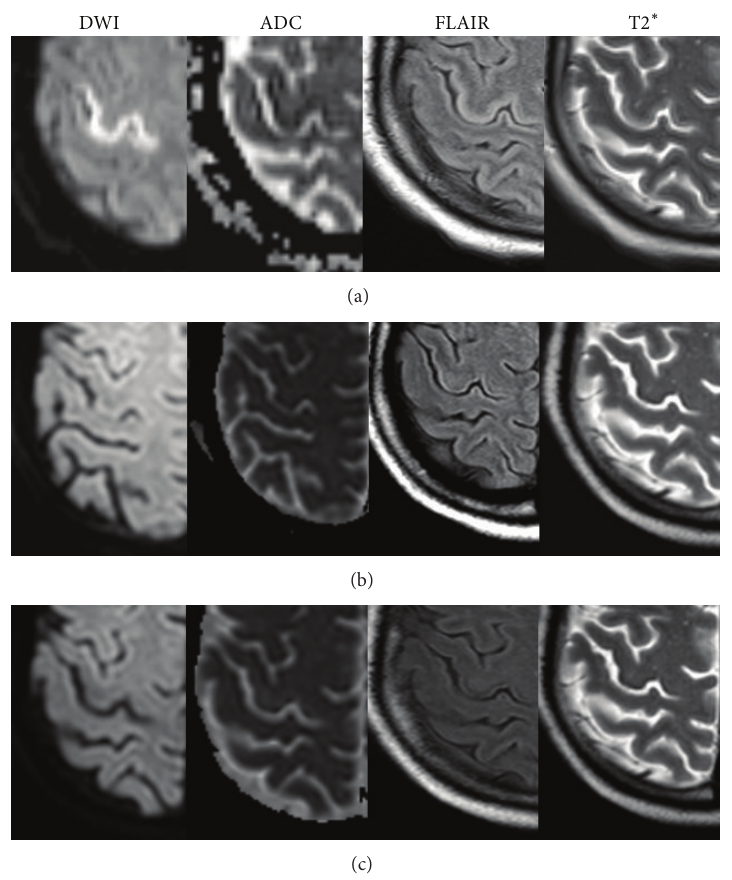
Figure 4: Laminar cortical infarcts with hemorrhagic transformation. (a) T2 ∗ showed asymmetrical hyperintense cortical lesions in right Rolandic region with restricted diffusion. (b) T2 ∗ showed hypointense signal changes in the same region, suggestive of hemorrhagic transformation. (c) No resolution of cortical